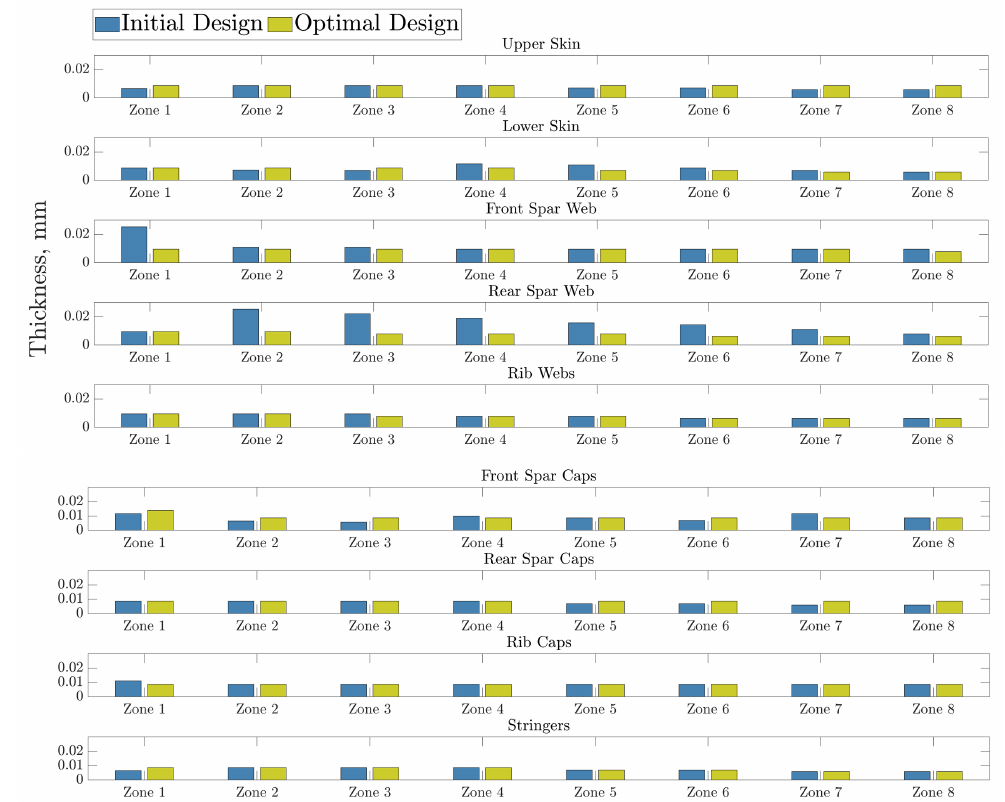
Figure 15. SBO thickness reduction at each part and zone of the reference